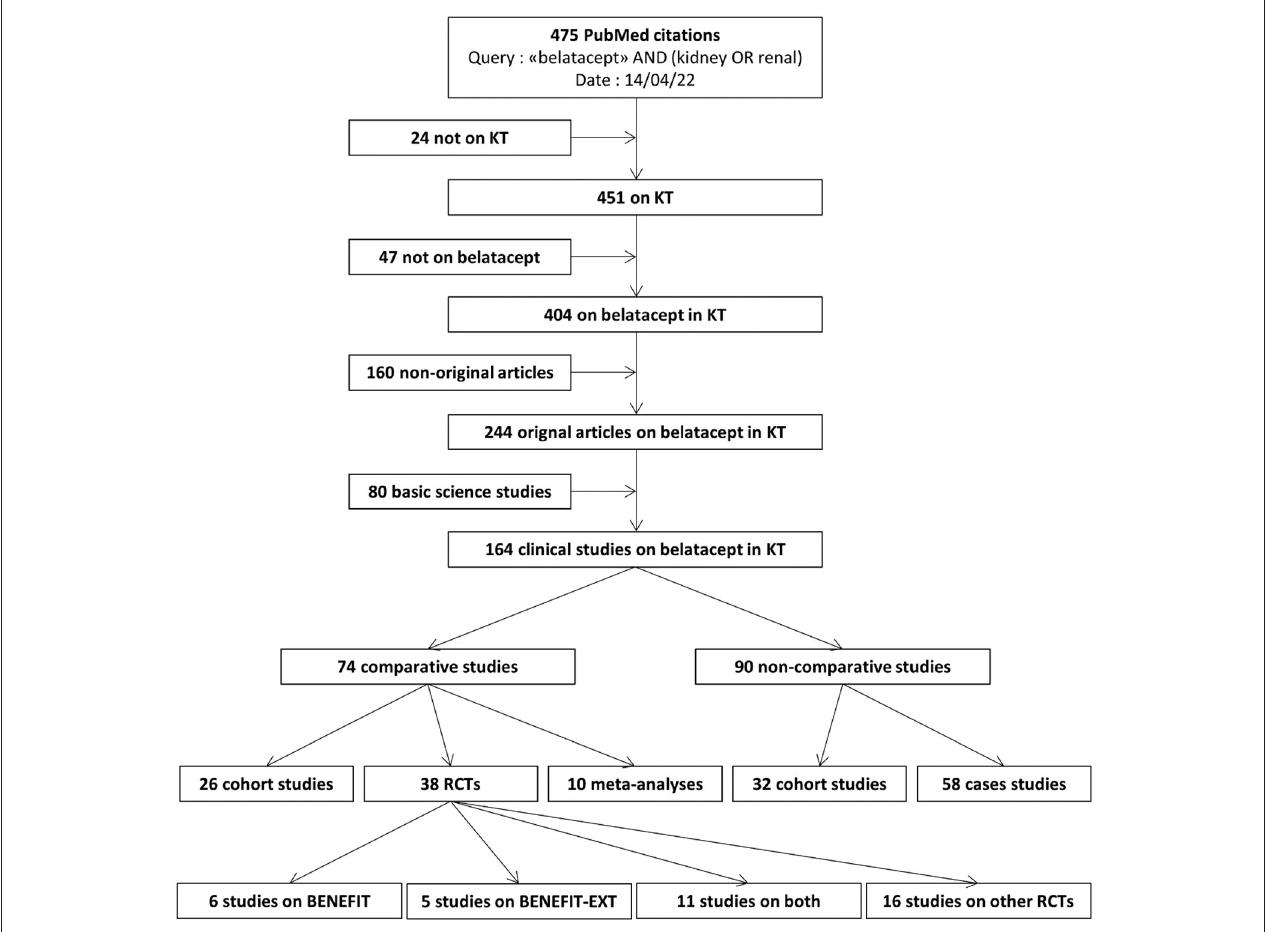
FIGURE 1 | Systematic review of the literature on belatacept in kidney transplantation. KT: kidney transplantation. RCT: randomized controlled trial.